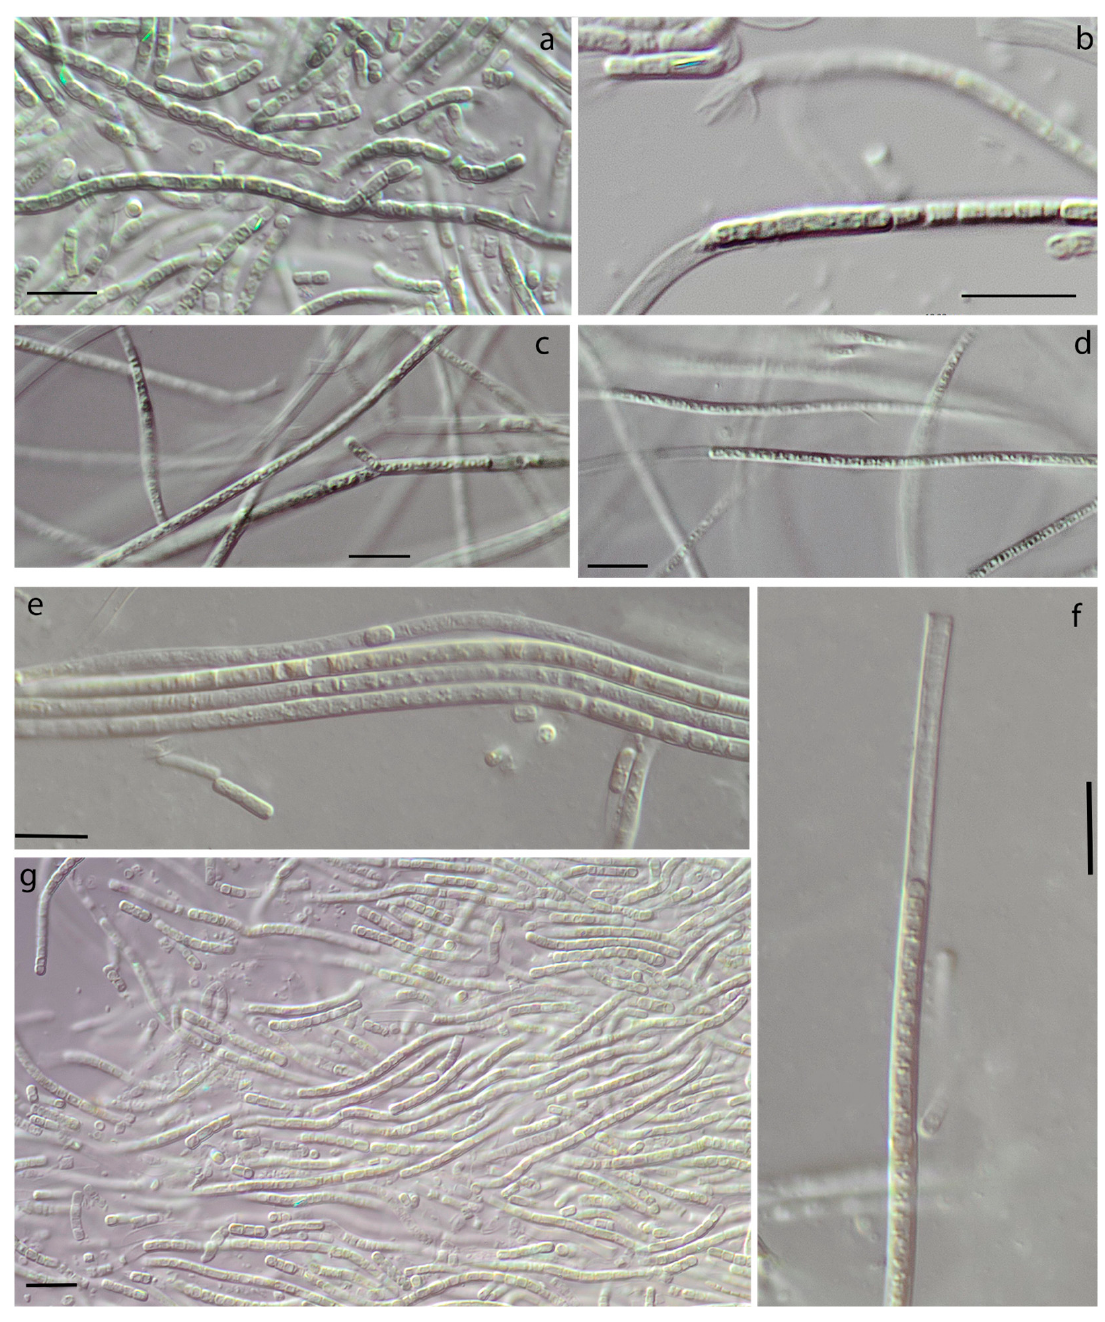
Figure 2. Light micrographs of Drouetiella strains: ( a , b ) Drouetiella lurida KPABG 4163; ( c , d ) Drouetiella lurida KPABG 41662; ( e , f ) Drouetiella lurida KPABG 610005; ( g ) Drouetiella hepatica KPABG 132178; ( b , d , f ) unbranching filaments with thin, firm sheaths; ( a , c ) false-branching filaments. All photos are at the same magnification, scale = 10 μ m.